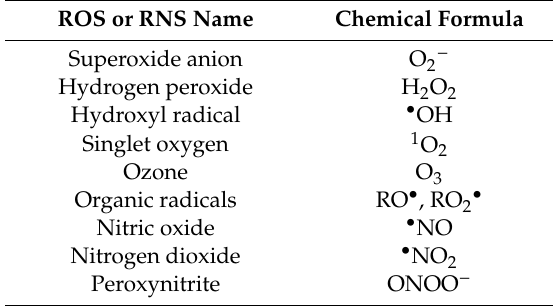
Figure 1. Schematics of atmospheric pressure plasma jet (APPJ) system with an image of the plasma torch. Image illustrates the entire physicochemical complexity of NTP. Table 1. Major types of reactive oxygen and nitrogen species form by non-thermal plasma (NTP).